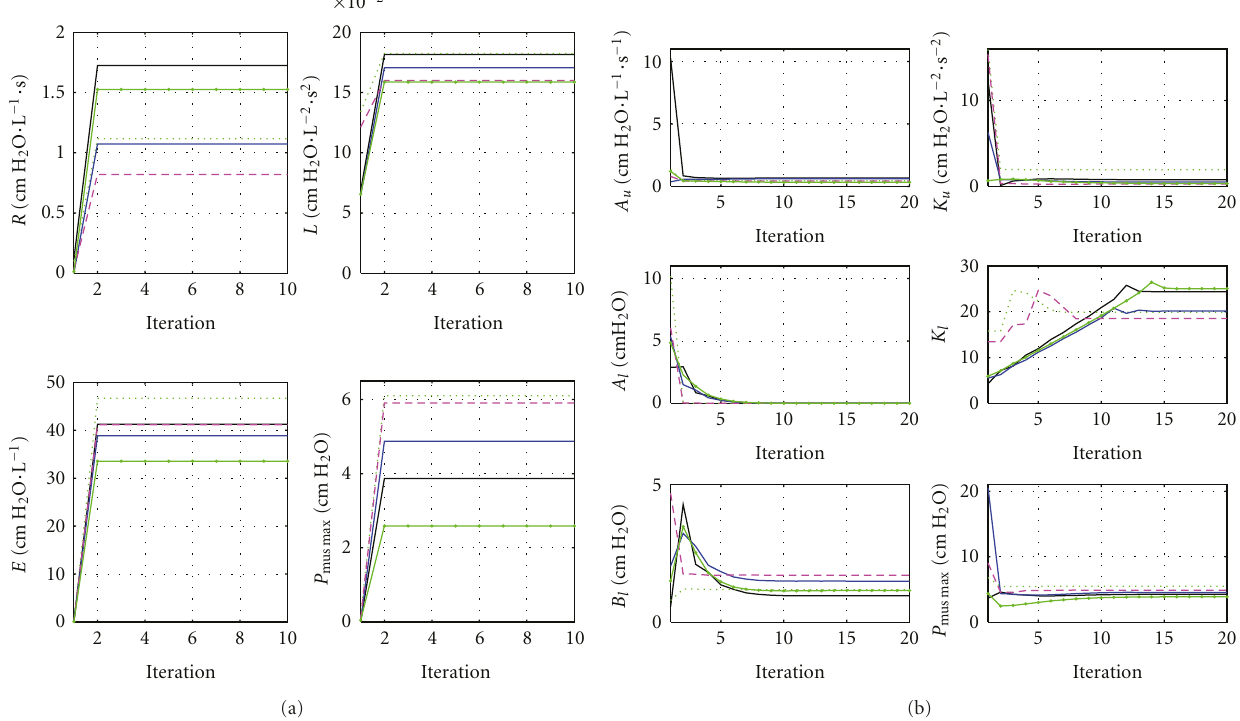
Figure 8: (a) Linear RIC model parameter estimation for five di ff erent breath cycles, produced by representative COPD patient’s signals. (b) Nonlinear model parameter estimation for five di ff erent breath cycles, produced by representative COPD patient’s signals.